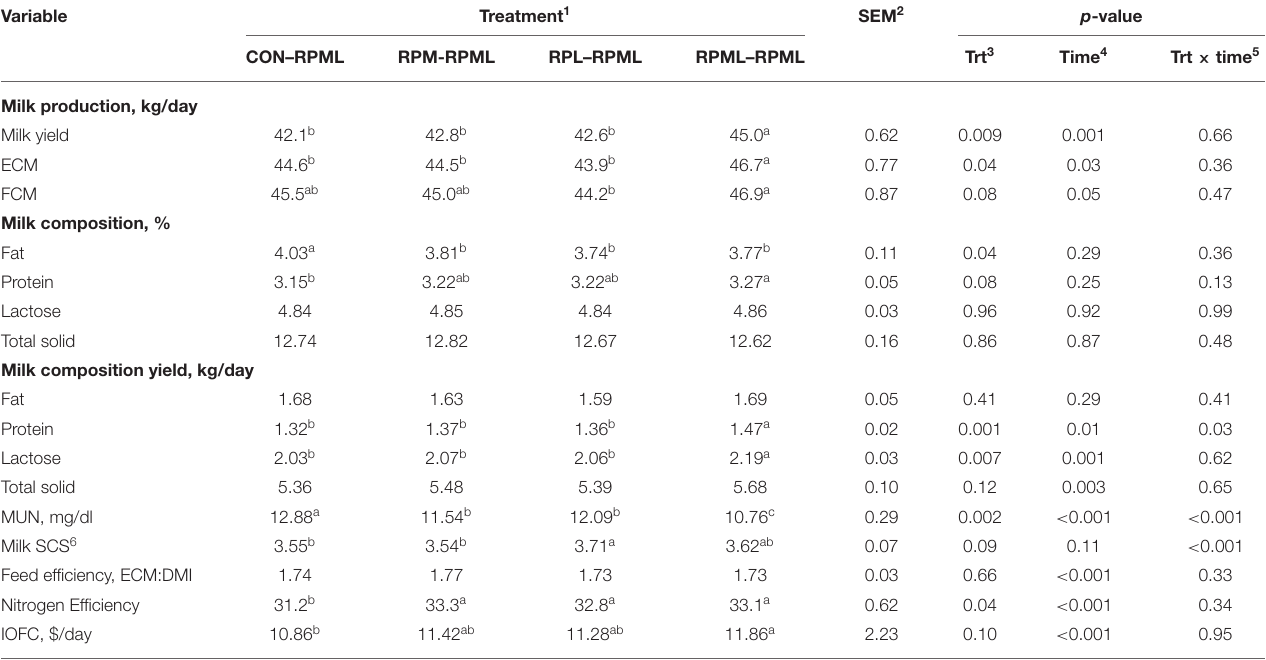
TABLE 5 | Feeding ruminally protected Met and Lys to transition dairy cows and its subsequent effect on post-calving performance.